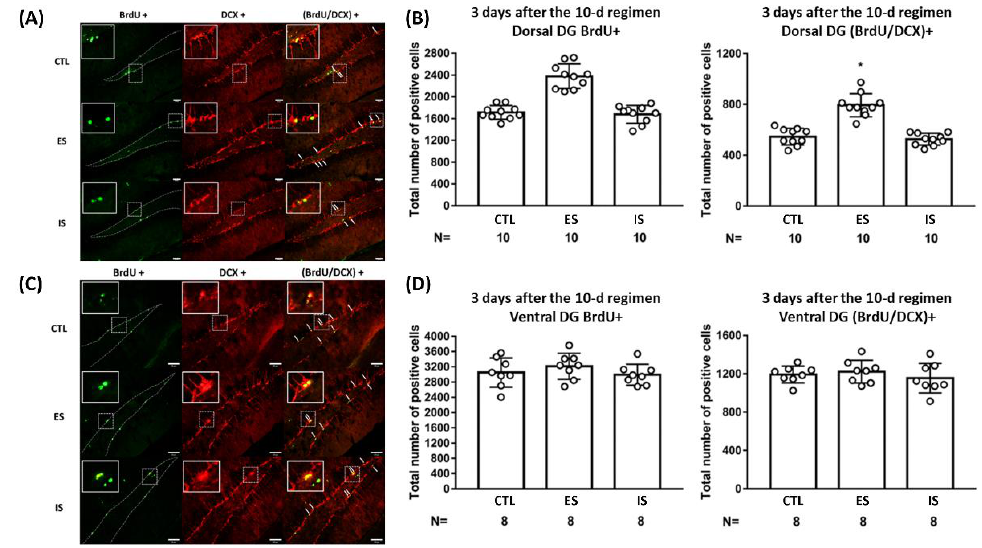
Figure 1. The impact of the footshock stressor and behavioral control on cell proliferation and early neurogenesis in the dorsal and ventral dentate gyrus (DG). ( A ) Representative photomicrographs of BrdU (green)-, DCX (red)-, and BrdU/DCX (yellow)-positive cells were listed in mouse dorsal DG. Staining cells were counted positive only when their locations were at the border (dotted lines) of suprapyramidal and infrapyramidal blades with consistent morphological standards [37]. White arrows point to (BrdU/DCX)-positive cells. Scale bar = 50 µm. ( B ) ES mice had a greater number of BrdU+ and (BrdU/DCX)+ cells compared to their respective IS and control (CTL) mice in the dorsal DG. * Significantly higher than the other groups. Histogram data are plotted as mean + SD. ( C ) Representative photomicrographs of BrdU (green)-, DCX (red)-, and BrdU/DCX (yellow)-positive cells were listed in the mouse ventral DG. Staining-positive cells were counted using the aforementioned standards. White arrows point to (BrdU/DCX)-positive cells. Scale bar = 50 µm. ( D ) Three groups of mice had an indistinct number of BrdU+ and (BrdU/DCX)+ cells in the ventral DG. Data are plotted as mean + SD.